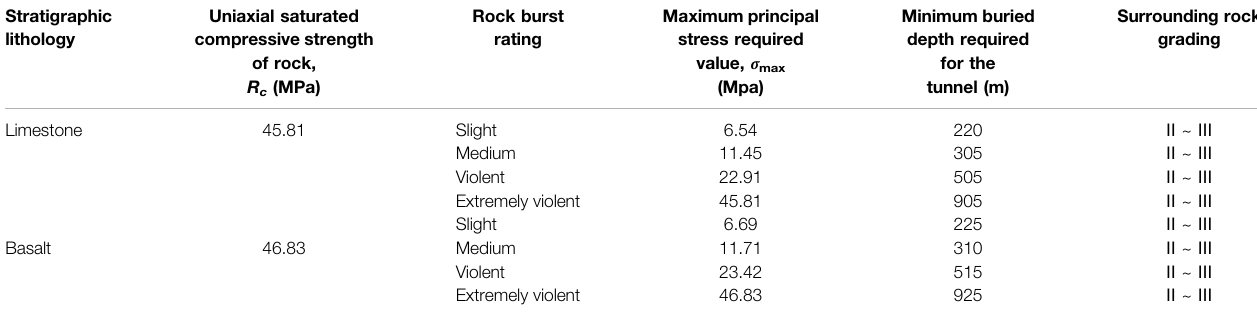
TABLE 5 | Buried depth required for rock burst in various stratum lithology. Stratigraphic lithology